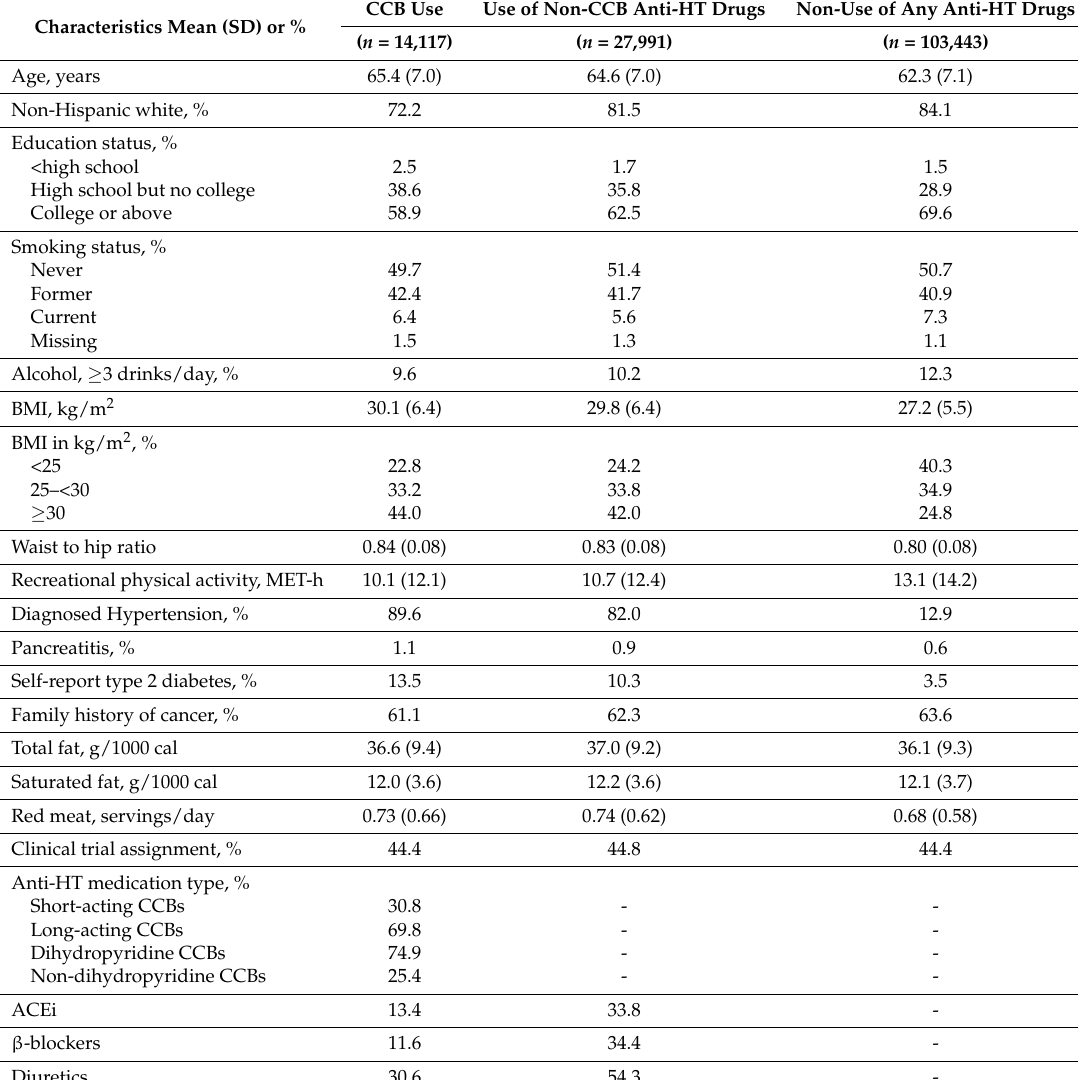
Table 1. Selected baseline characteristics by anti-hypertensive (HT) medication use status among postmenopausal women in the Women Health Initiative Study ( n =